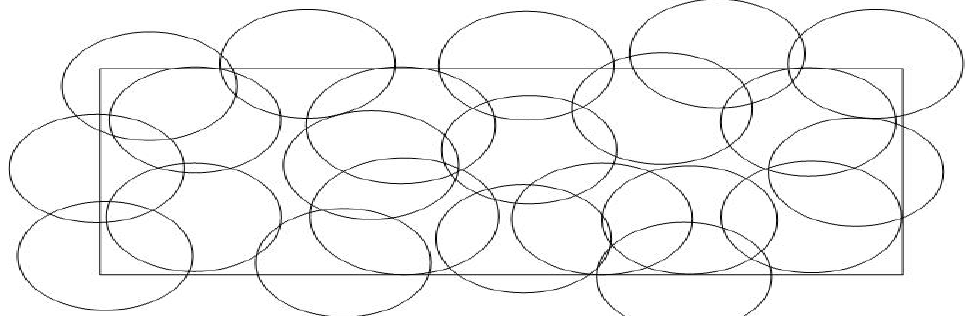
Figure 6. Random deployment.